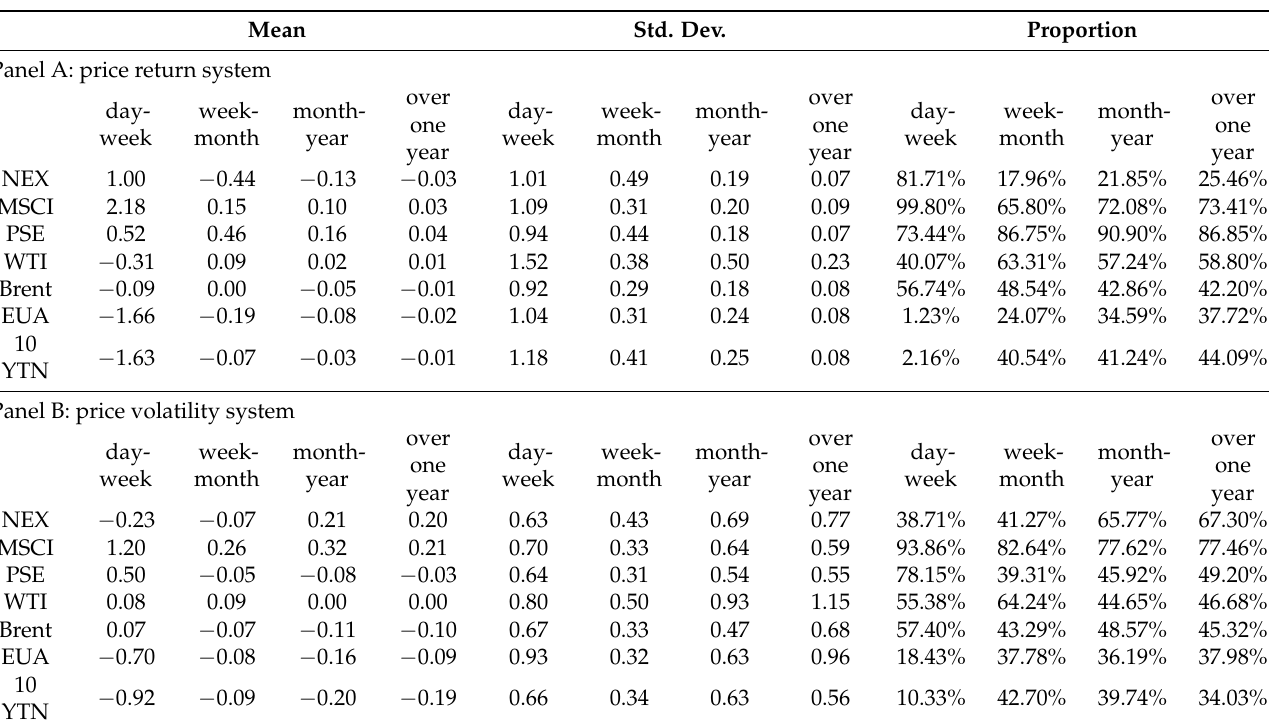
Table A1. Summary statistics of net pairwise connectedness between NEX and other